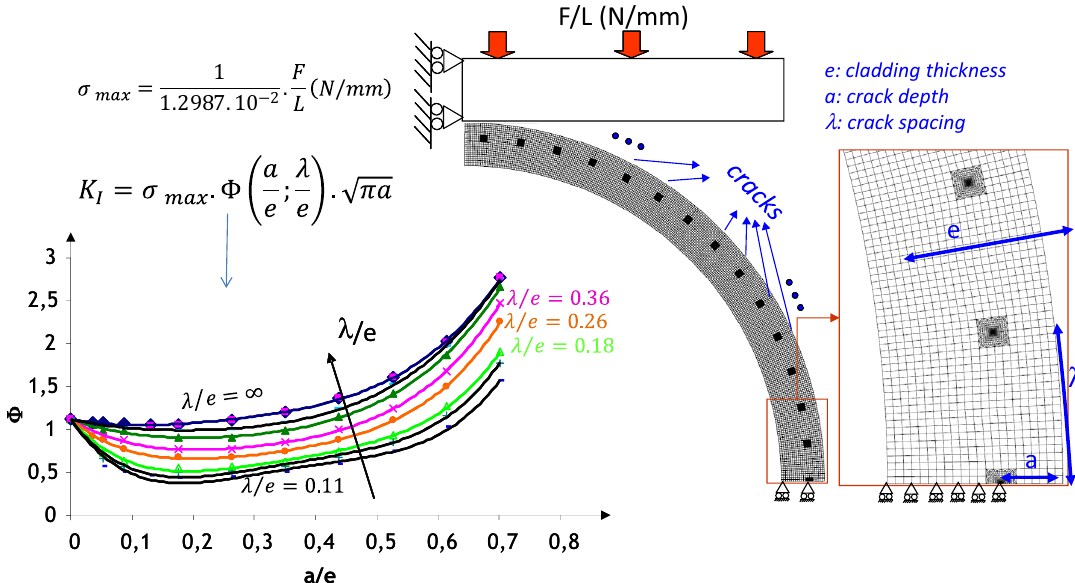
Fig. 5. Stress intensity factor at outer diameter equatorial location during CCT with multiple crack nucleation (marks: calculated values; lines: correlated values).